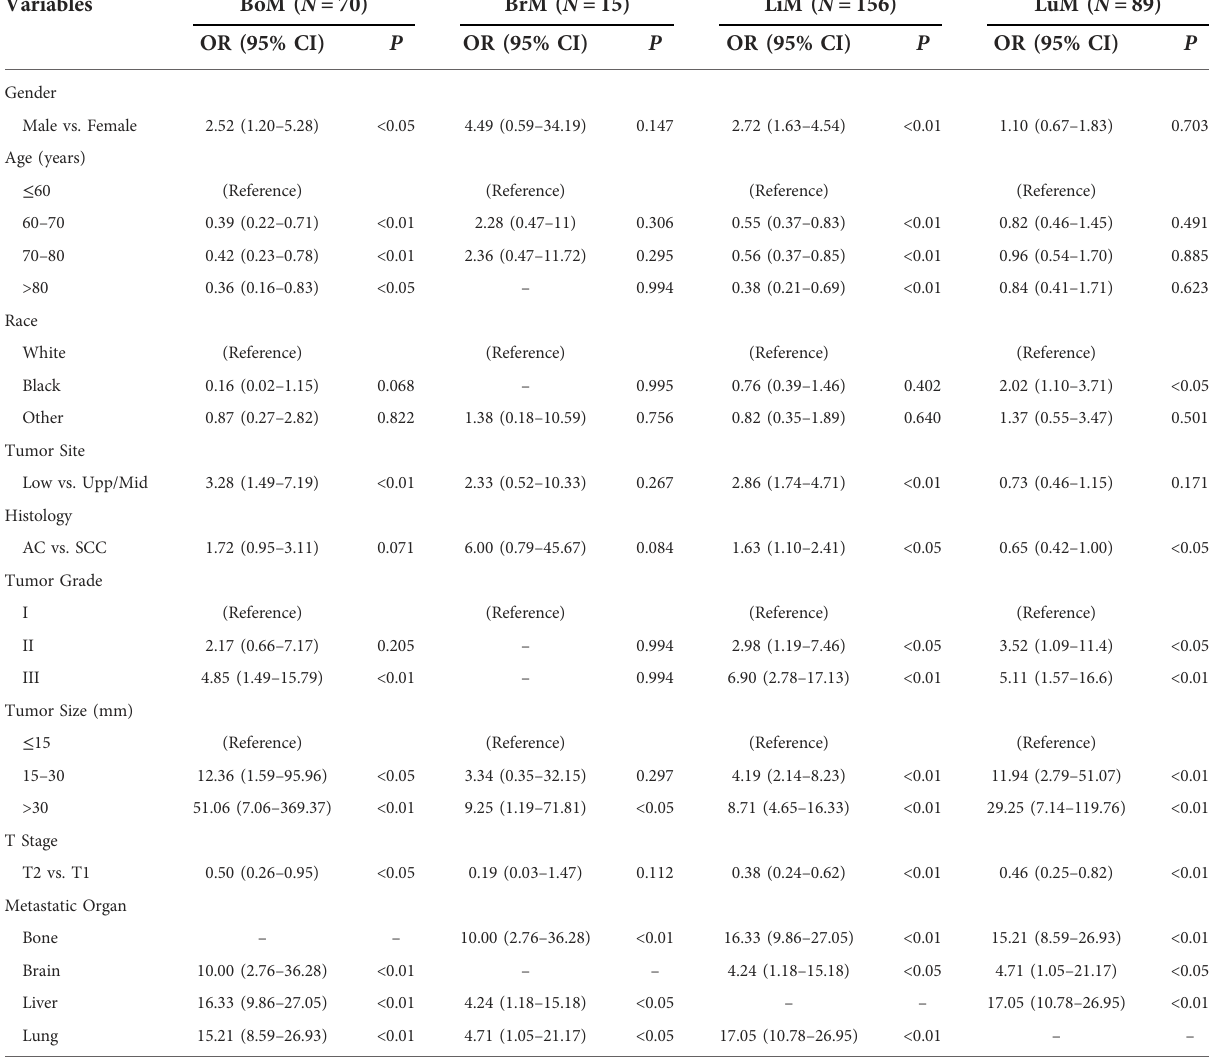
TABLE 3 Multivariate analyses of variables associated with bone, brain, liver and lung metastases.